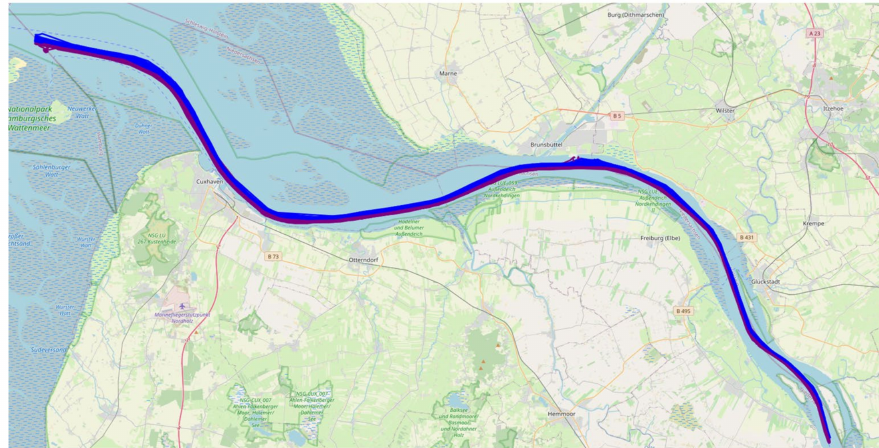
Figure 6. Coverage of the German Bight by the AIS stations in Brunsbüttel, Cuxhaven, and Wilhelmshaven. The black polygon highlights the Elbe River as the study area for this work.